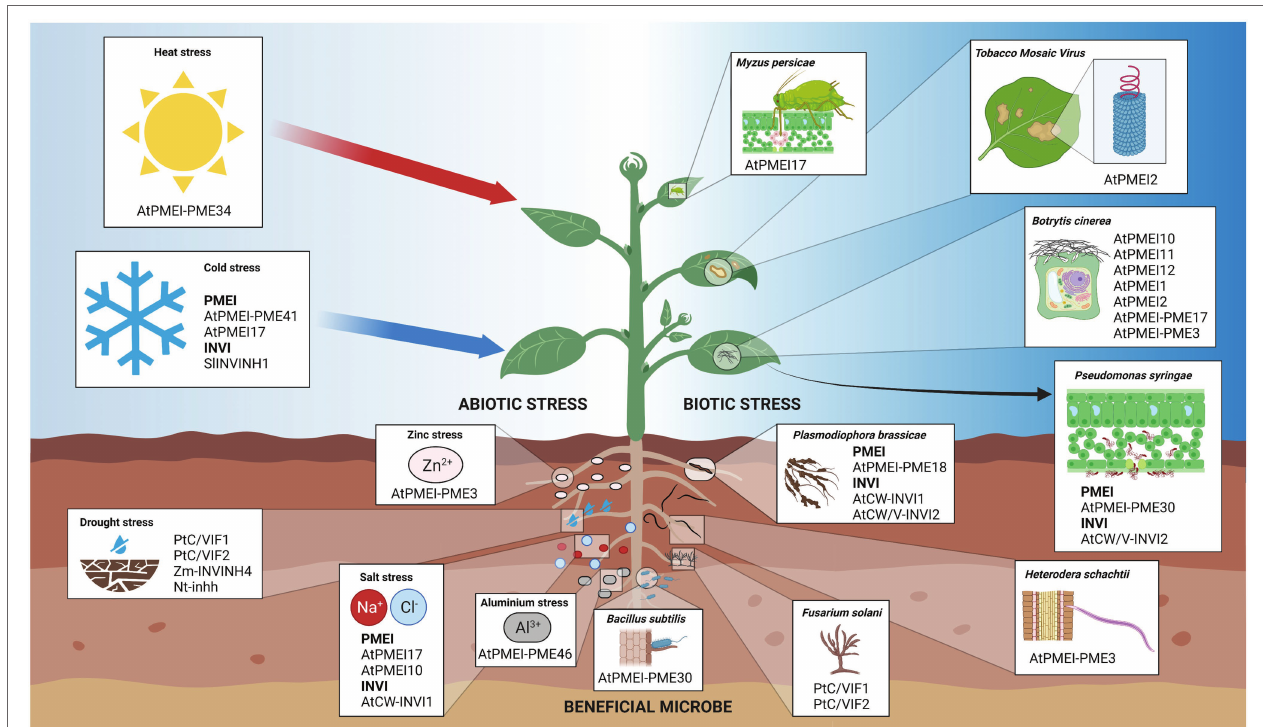
FIGURE 6 | Schematic representation of the involvement of INVI/PMEI members in plant-environment interactions. Plants face different pathogens and pests, such as bacteria, nematodes, fungi, viruses, and insects as well as multiple abiotic stresses. Different INVI/PMEI members have a pivotal role plant-microbe associations beneficial to the host plant like also during multiple plant-pathogen interactions. PMEIs and INVIs are also involved in plant responsiveness to different abiotic stresses and in heavy metal